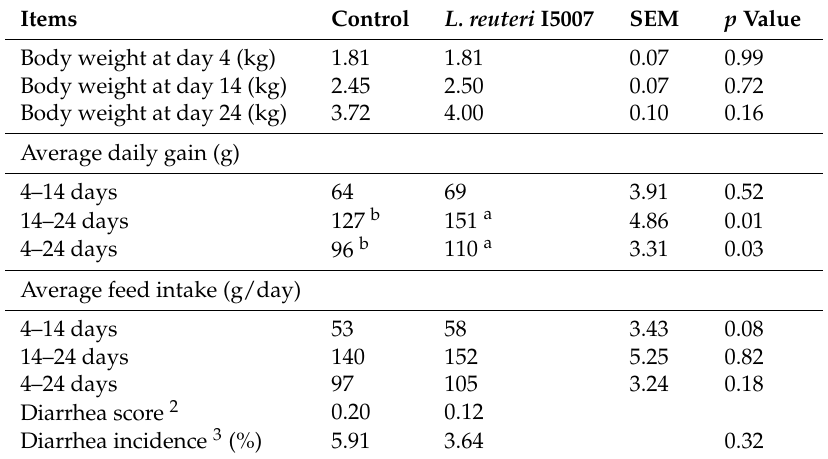
Table 2. Effects of L. reuteri I5007 on neonatal piglet performance and diarrhea incidence 1